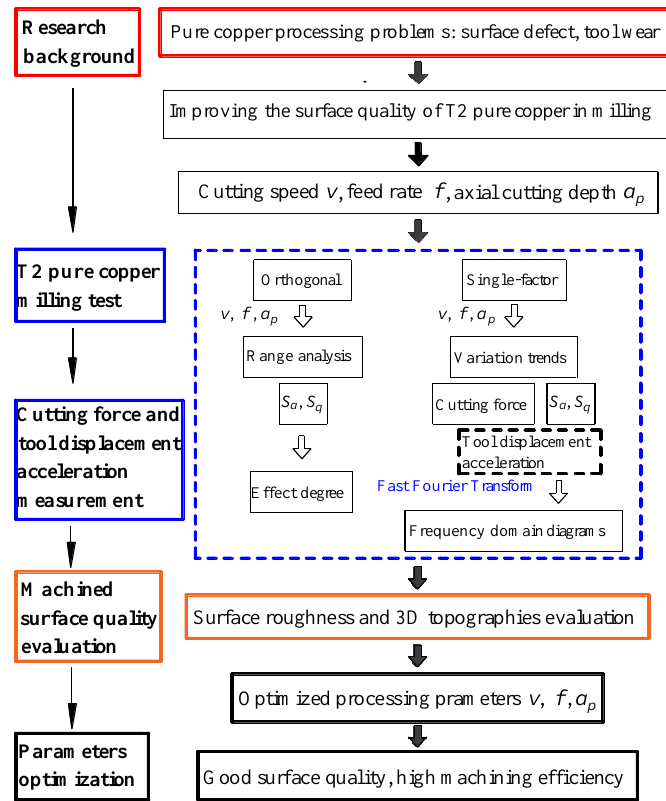
Figure 2. The framework of the study and research technology roadmap.